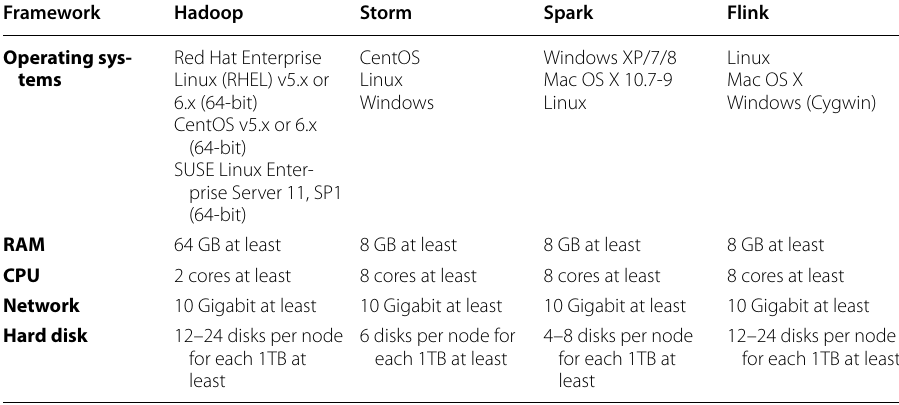
Table 2 Hardware requirements of some Big Data processing frameworks